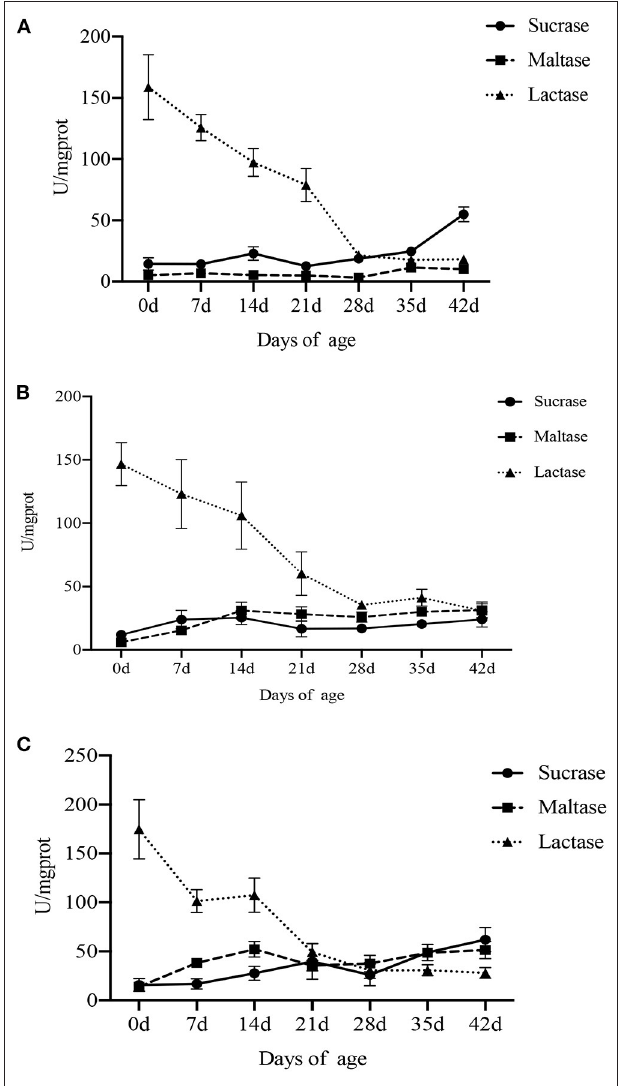
FIGURE 2 | Effect of piglet age on intestinal disaccharidase activity. (A) Duodenum. (B) Jejunum. (C) Ileum. Values are expressed as means ± SEM.